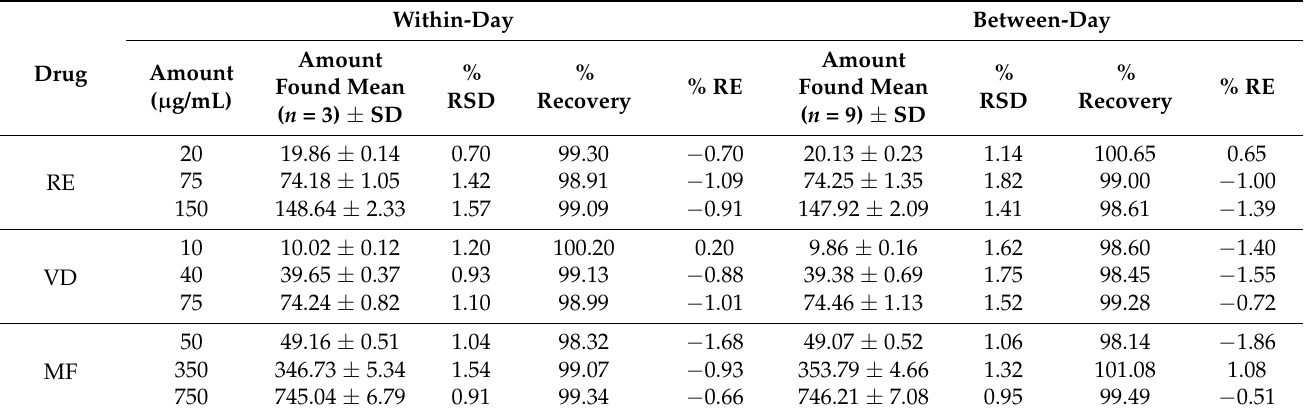
Table 4. Precision and accuracy results of the developed HILIC